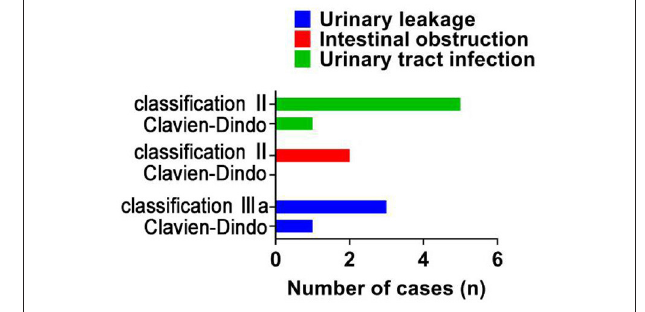
FIGURE 1 | Comparison of incidence of complications.